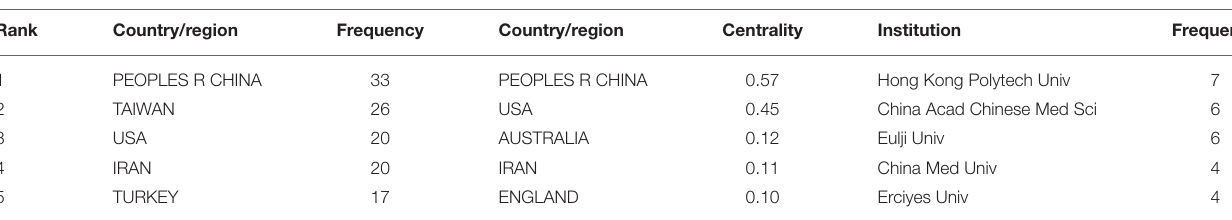
TABLE 1 | Top 5 country/region and institute. Rank Country/region Frequency